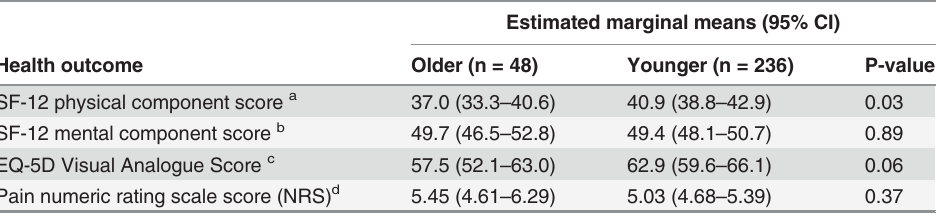
Table 2. Quality of life scores and severity of pain among older ( (cid:1) 65 years) and younger (18 – 64 years) participants 12 months after a mild/ moderate musculoskeletal injury (n = 284).